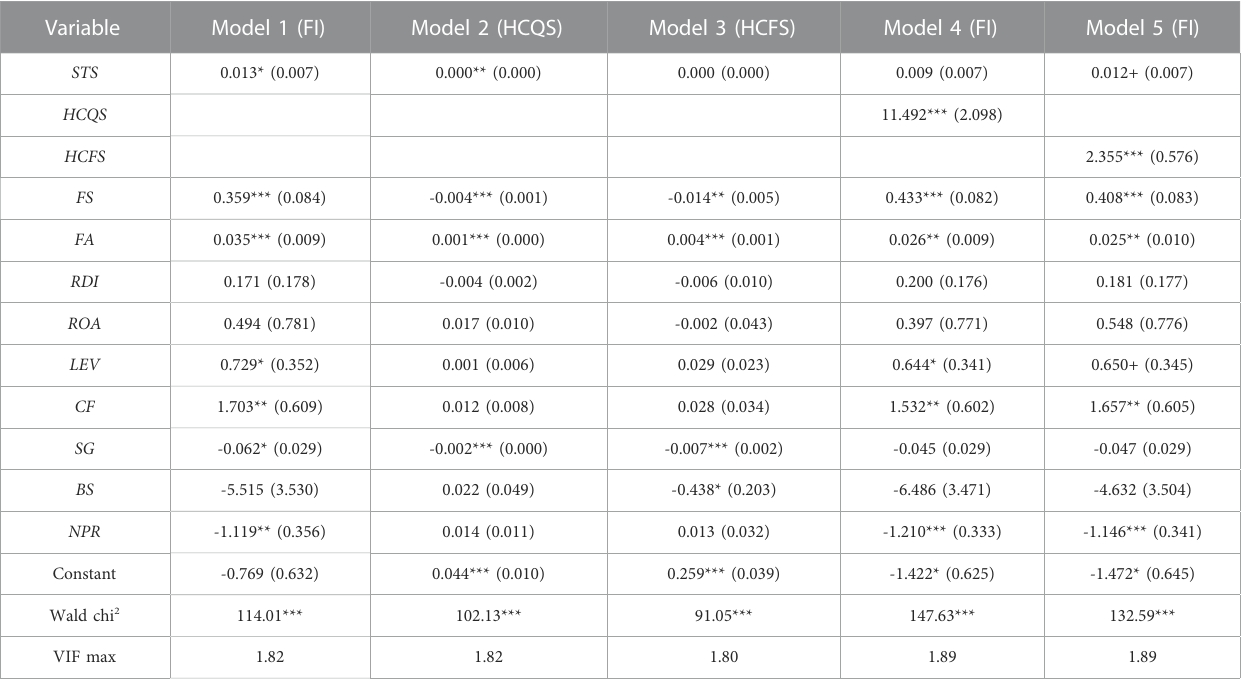
TABLE 5 Regression analysis.